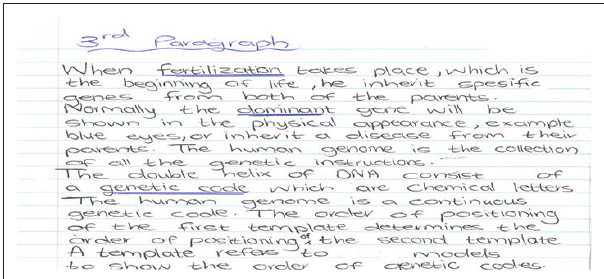
FIGURE 2: Excerpt